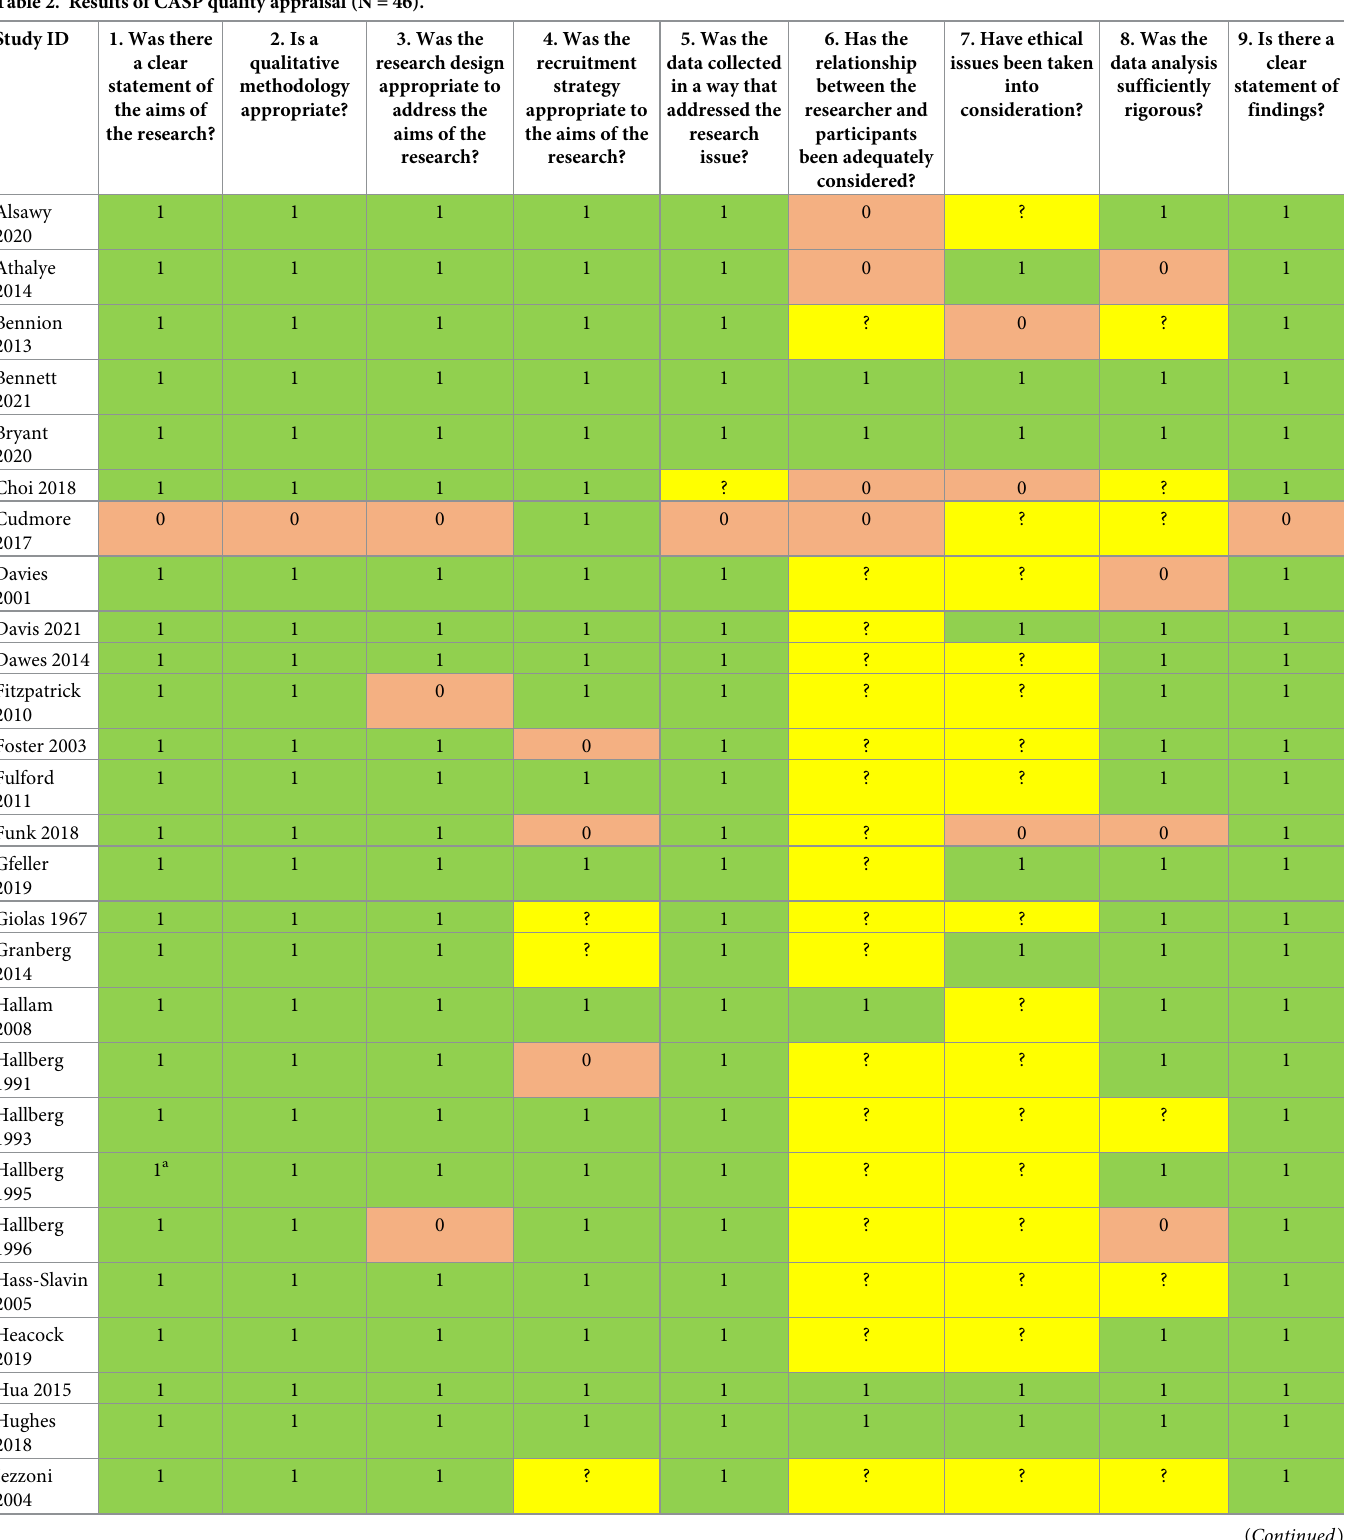
Table 2. Results of CASP quality appraisal (N =